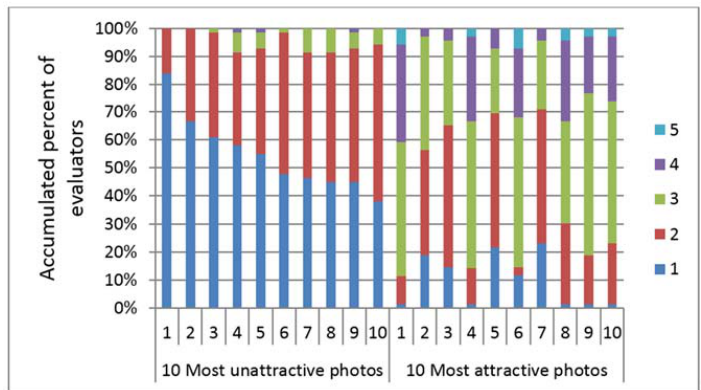
Figure 4. Comparison between accumulated percent of evaluators evaluated the 10 most unattractive and 10 most attractive 2D photos. Evaluators evaluated the 10 most unattractive faces (within 2 scales) more consistency than evaluated the 10 most attractive faces (within 5 scales).